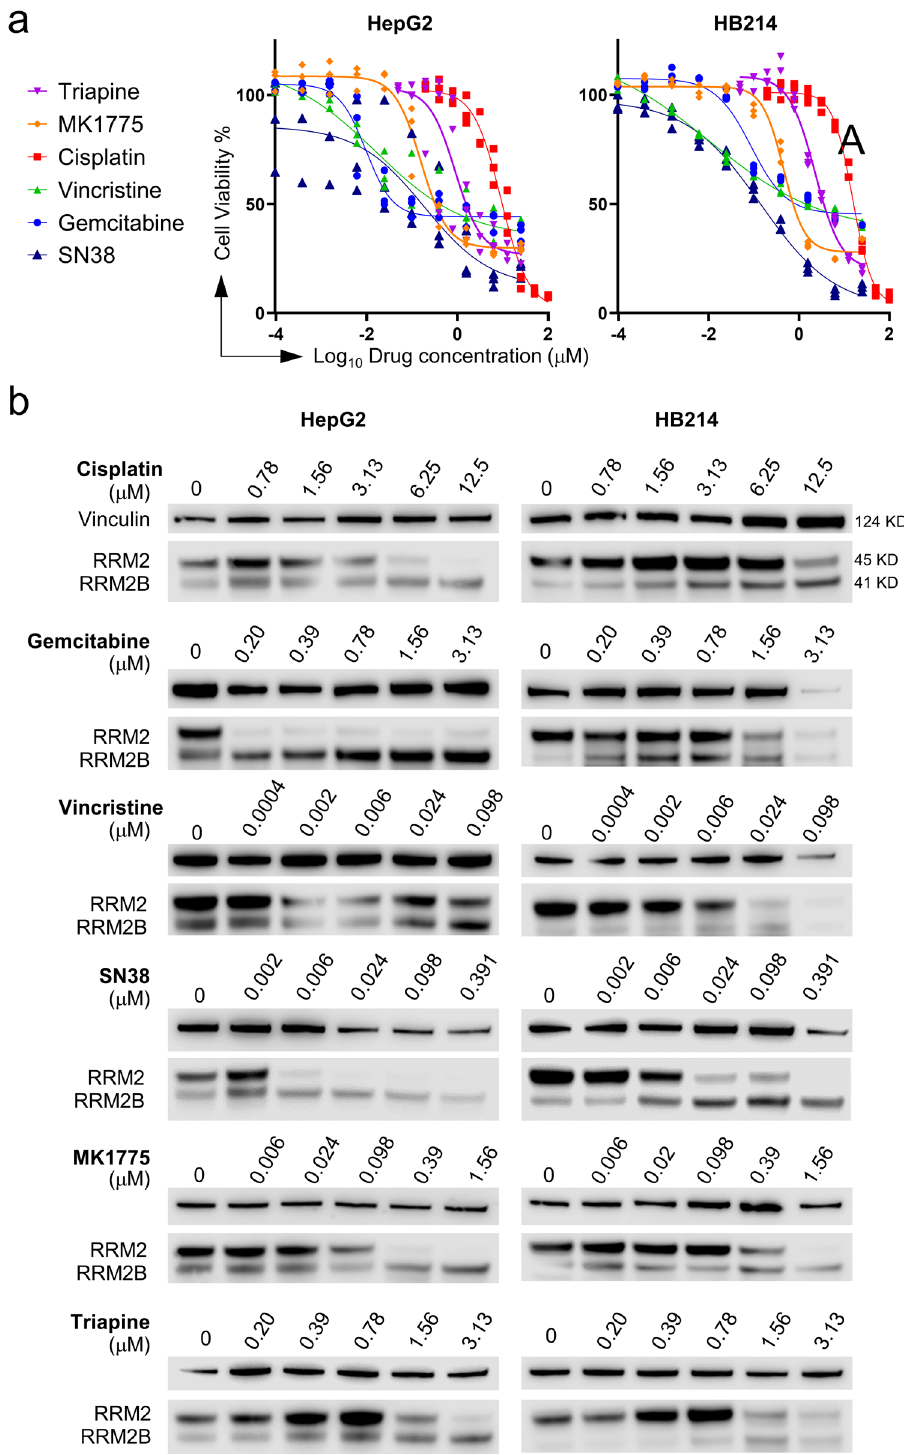
Fig. 4 A drug-induced RRM2 to RRM2B subunit switch in HB cells in vitro. a The dose-response curves of HepG2 and HB214 cells treated with the indicated chemotherapeutic agents and RRM2 inhibitors ( n = 3 for each group). b RRM2 and RRM2B immunoblotting HepG2 and HB214 cells with the indicated